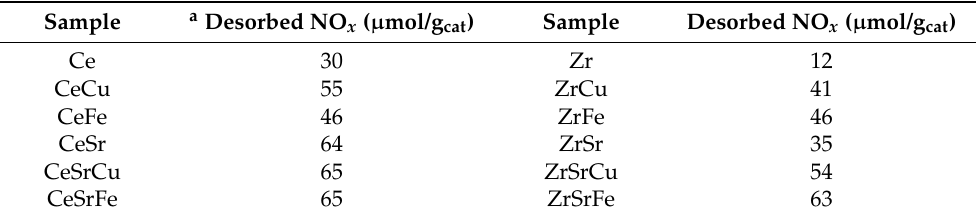
Table 2. Desorption of NO x based on NO x ‐ TPD experiments.